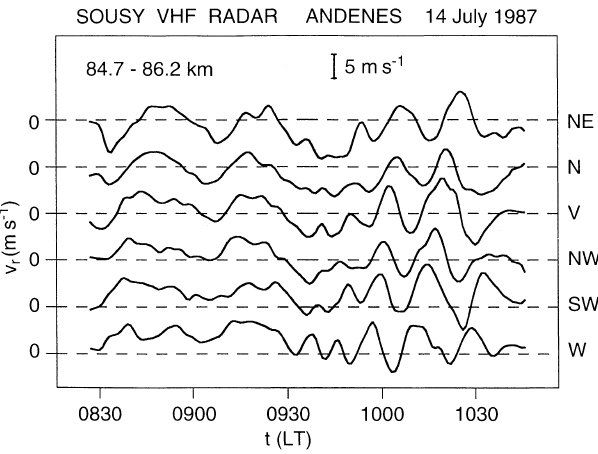
Fig. 9. Height integrated (84.3–86.2 km) time series of the radial velocities observed in all